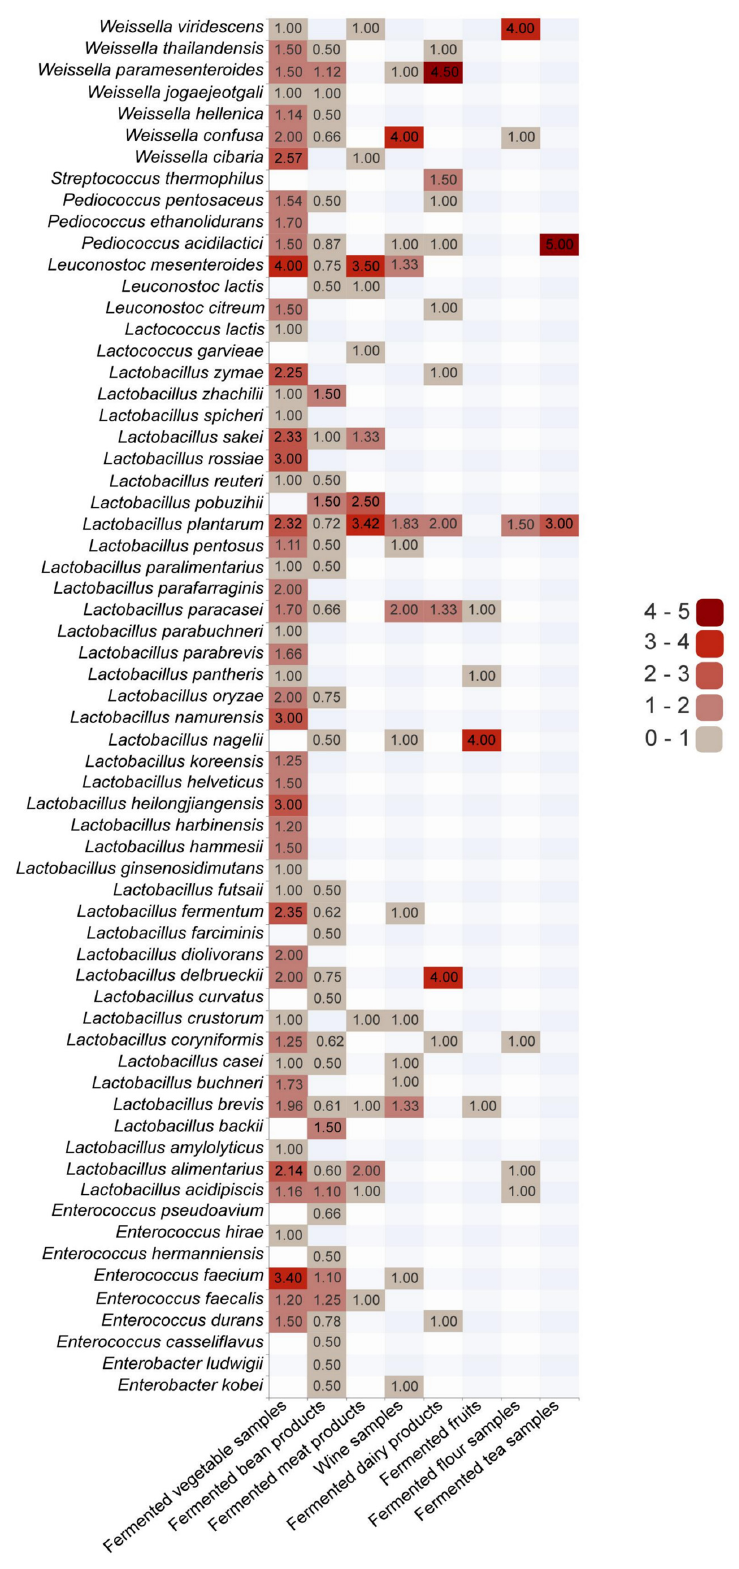
Figure 3. Heat map of the diversity coefficient of LAB in different fermented foods.